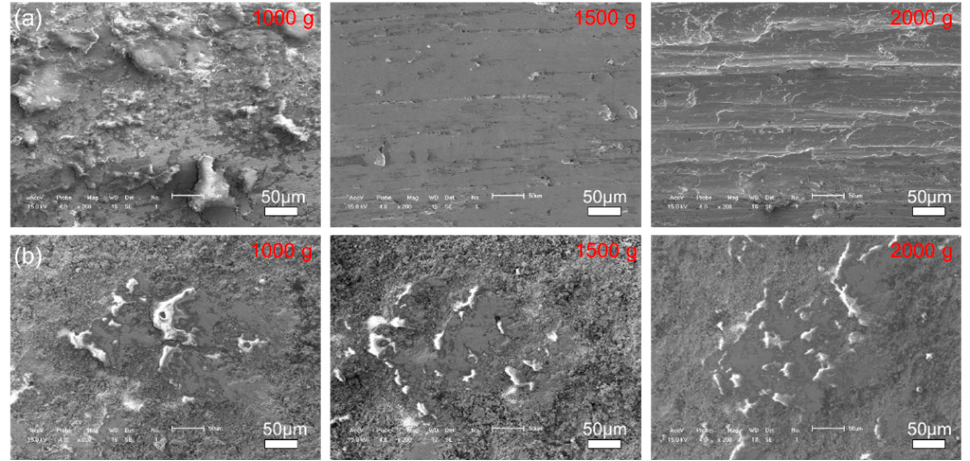
Figure 12. The morphologies of the wear surface of the ( a ) 27CrMoV substrate and ( b ) WC–10Co4Cr coatings after friction test at different loads.